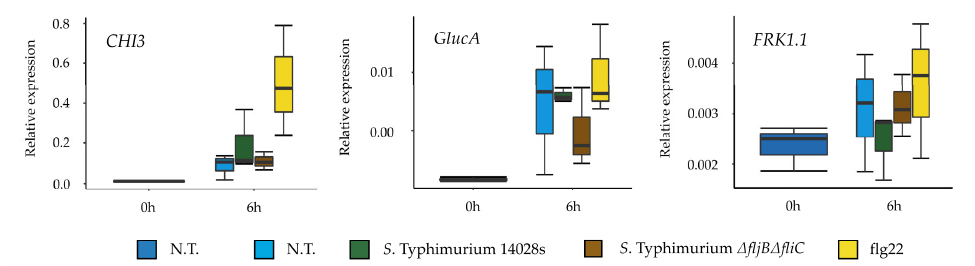
Figure 8. Expression of tomato defense genes is induced upon contact with Salmonella’s flagellin. Response to inoculation with S. Typhimurium 14028s, the double mutant S. Typhimurium ∆ fljB ∆ fliC as well as 100 nM flg22 was monitored in tomato plants by assessing the transcriptional activation of CHI3 , GlucA , and FRK1.1 . The expression was normalized using the expression of tomato Actin . The amount of mRNA was assessed also in non-treated plants (N.T.). The experiment was conducted in three replicates, where three plants per treatment were pooled and used for RNA extraction. For information about significant differences among treatments, please see Supplementary Table S3.